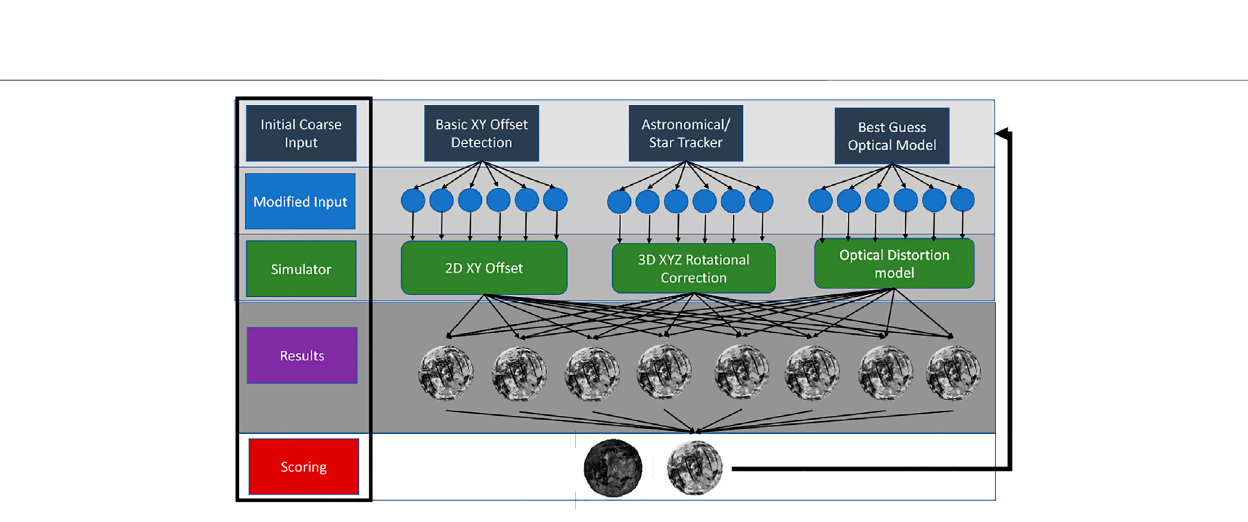
FIGURE 6 | Diagram demonstrating back propagation correction for the EPIC